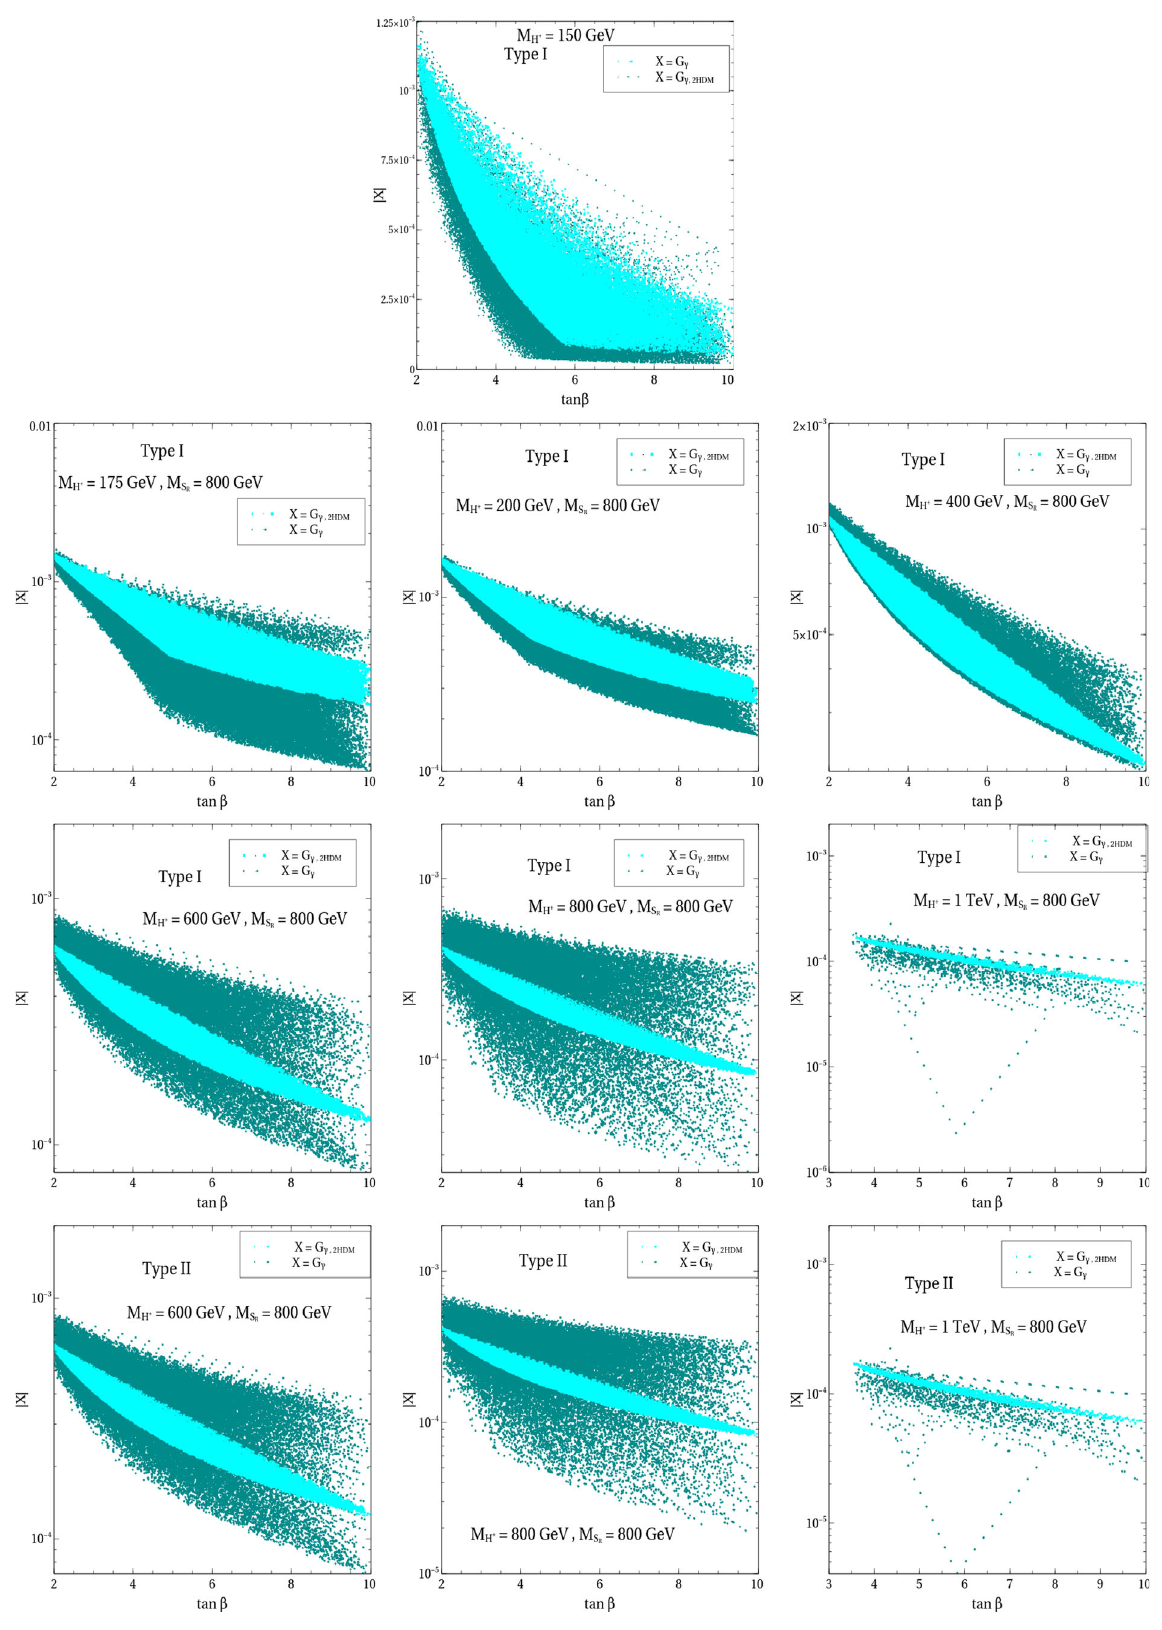
Fig. 11 Variation of absolute value of the form factors X = G γ , G γ, 2HDM with tan β for M H + = 175 , 200 , 400 , 600 , 800 , 1000 GeV and = 800 GeV for Type-I and Type-II 2HDM. Color coding is expressed in M S R